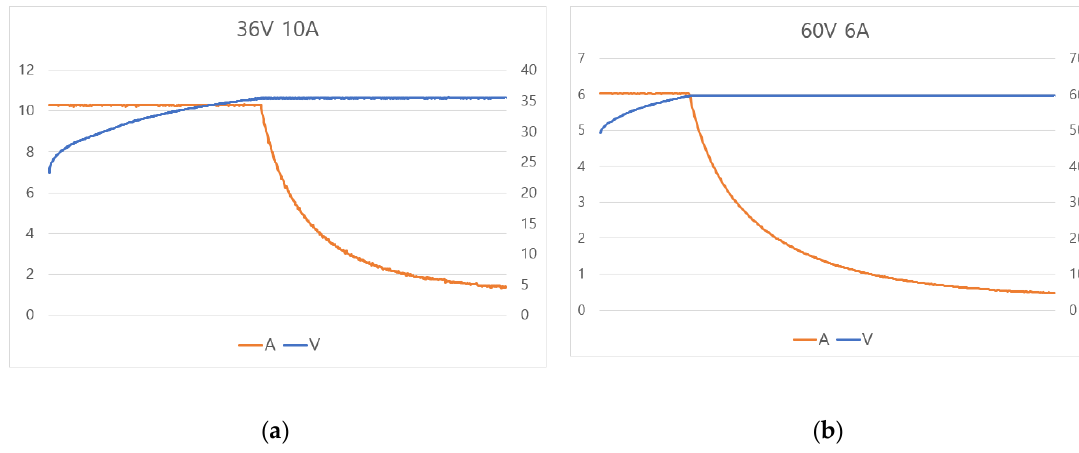
Figure 17. Battery charging results for ( a ) 36 V / 10 A and ( b ) 60 V / 6 A.